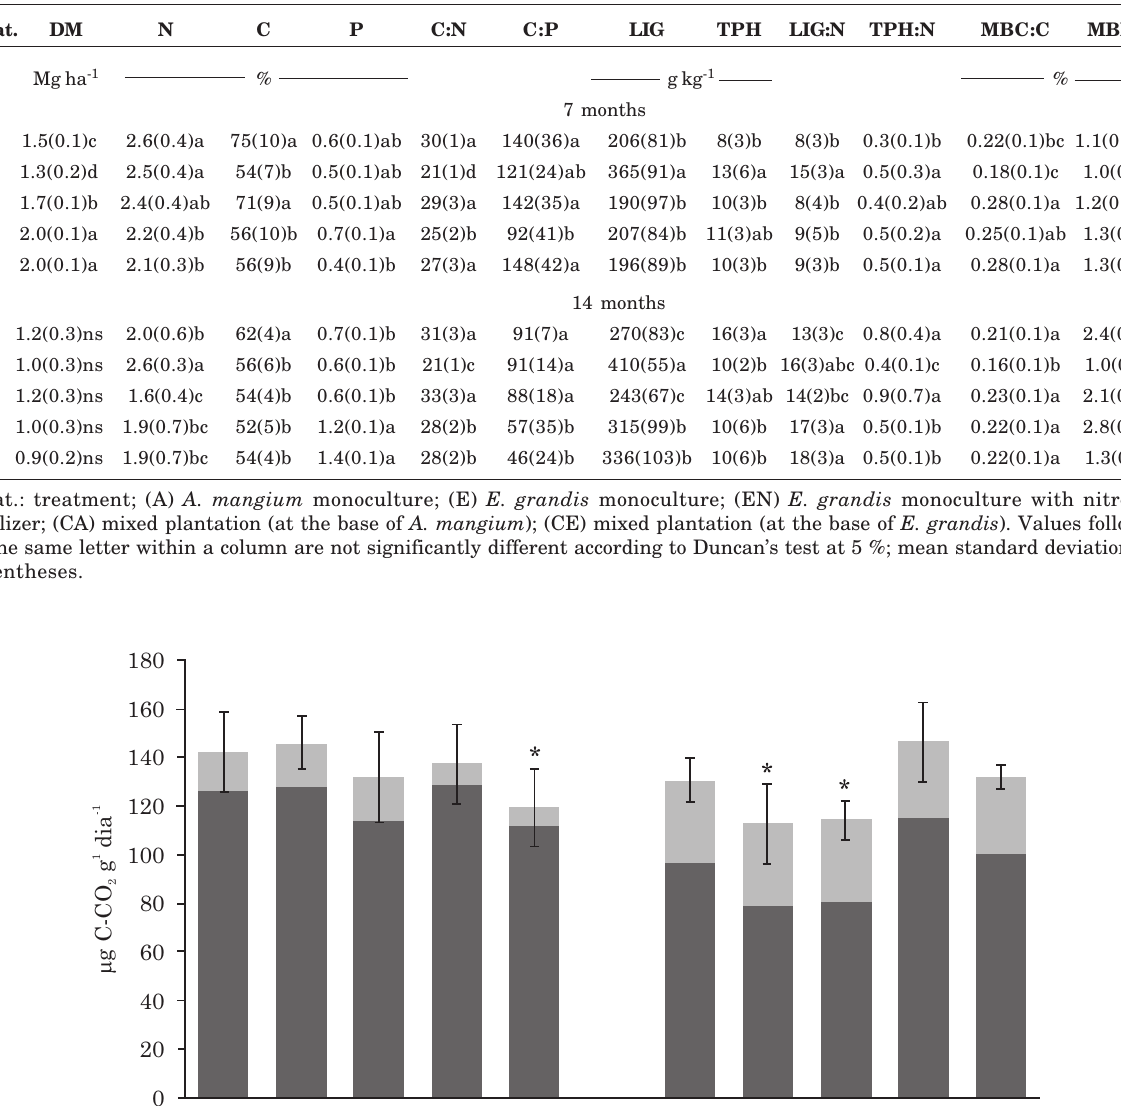
Table 1. Chemical analysis of litter in different treatments seven and 14 months after planting: dry matter (DM), nitrogen (N), carbon (C), phosphorus (P), C:N and C:P ratios, content of lignin (LIG) and